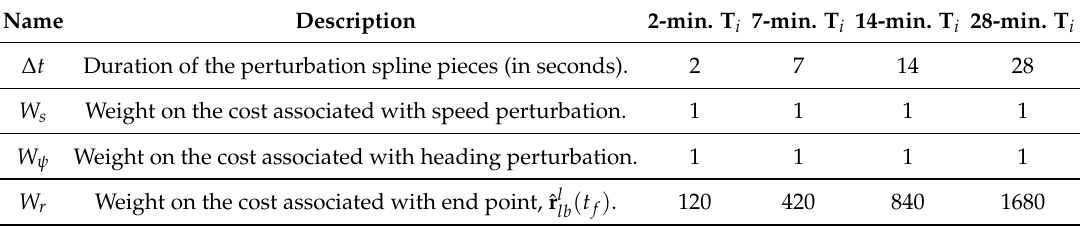
Table 3. Trajectory estimation hyperparameters for varying trajectory segment